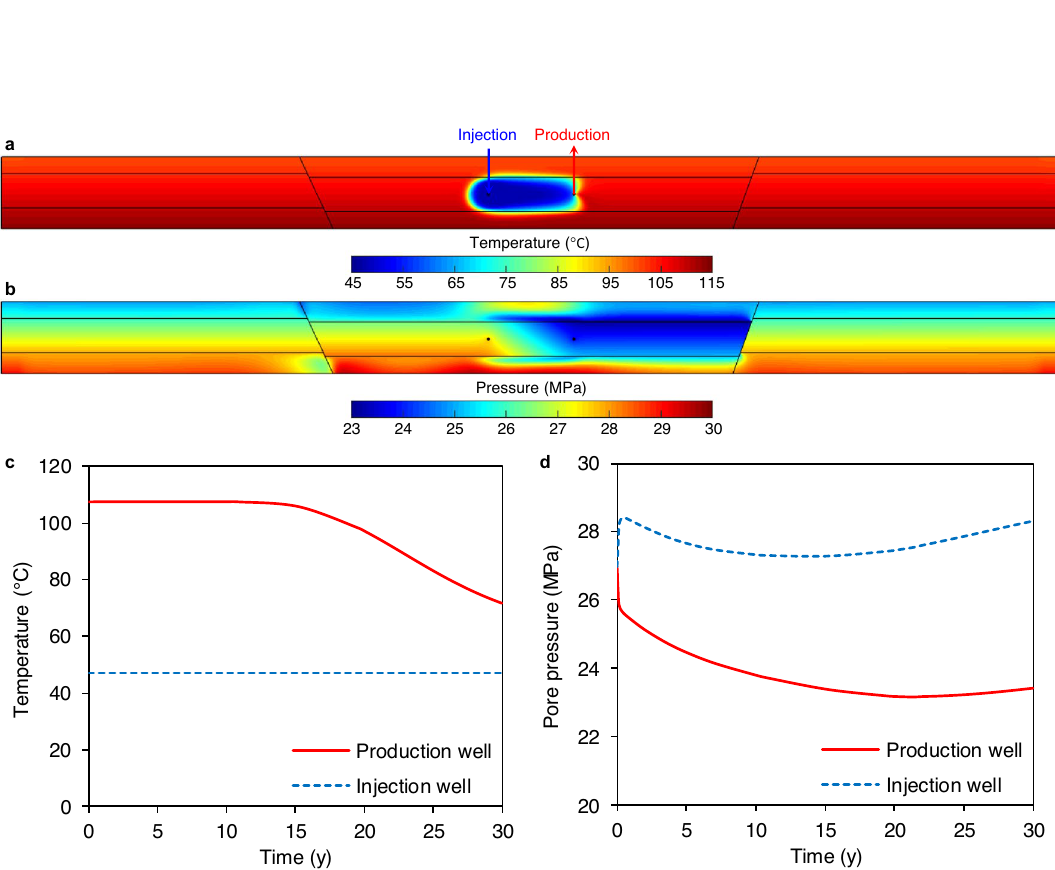
Figure 2. Temperature and pressure evolutions. Spatial distribution of temperature ( a ) and pore pressure ( b ) after 30 years of fluid circulation in a geothermal doublet in a HSA surrounded by low-permeable faults. The evolution with time of temperature ( c ) and pressure ( d ) at the reinjection and production